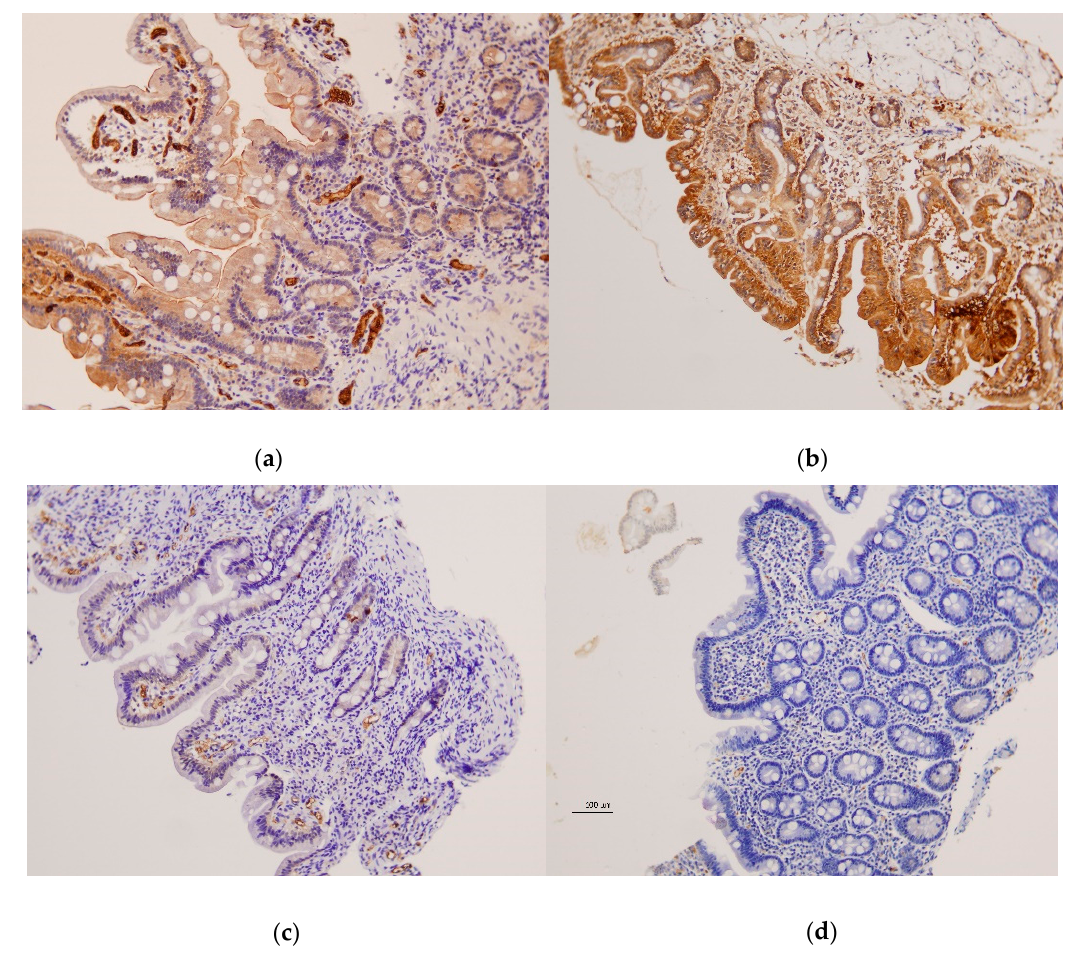
Figure 3. Protein expression of CX3CL1 in duodenal tissue obtained by immunohistochemistry (10 × ). Data correspond to paired samples of a non-coeliac disease (CD) individual with ( a ) normal histology and ( b ) atrophy; and a CD patient with ( c ) normal histology and ( d ) atrophy.